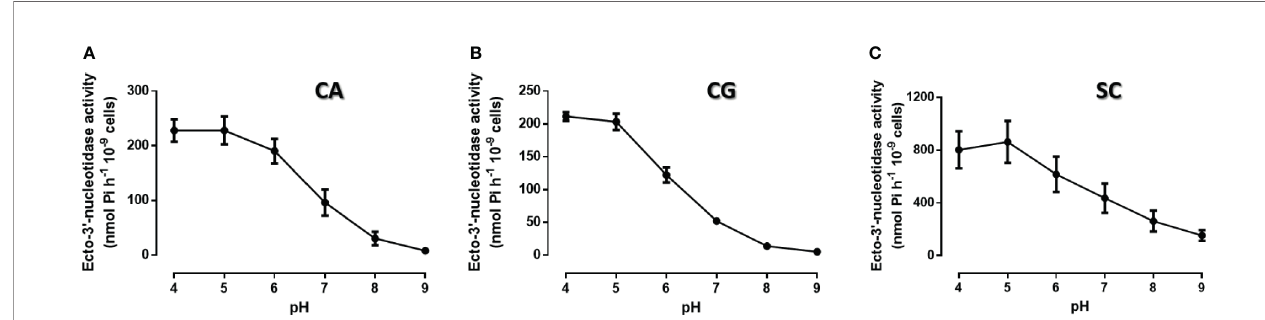
FIGURE 1 | Ecto-3 ′ -nucleotidase activity at different pH conditions. Intact cells of C. albicans ( A , CA), C. glabrata ( B , CG) and S . cerevisiae ( C , SC) were allowed to cleave 3 ′ AMP for 1 h at room temperature, at different pH conditions. All yeasts present maximum ecto-3 ′ -nucleotidase activity at pH 4.0. Data are shown as means ± SEM of at least three